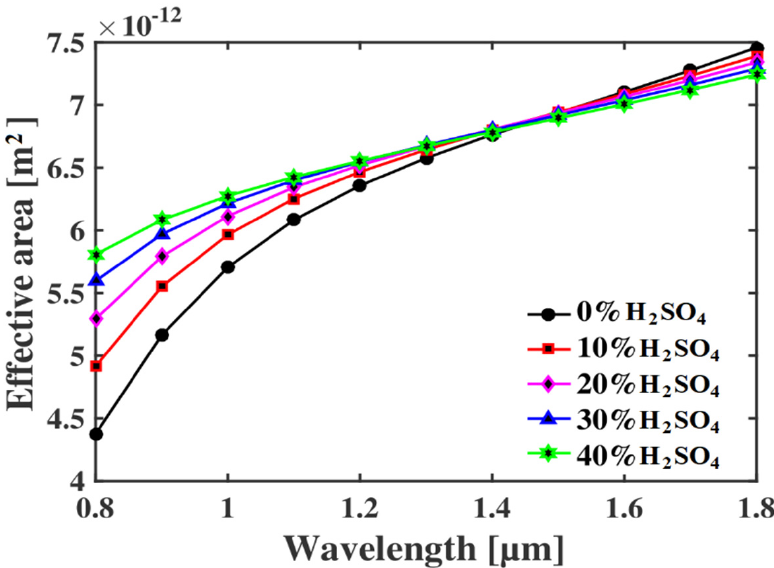
Figure 7. Relationship between the effective area and the operating wavelength at p = 3 µm.